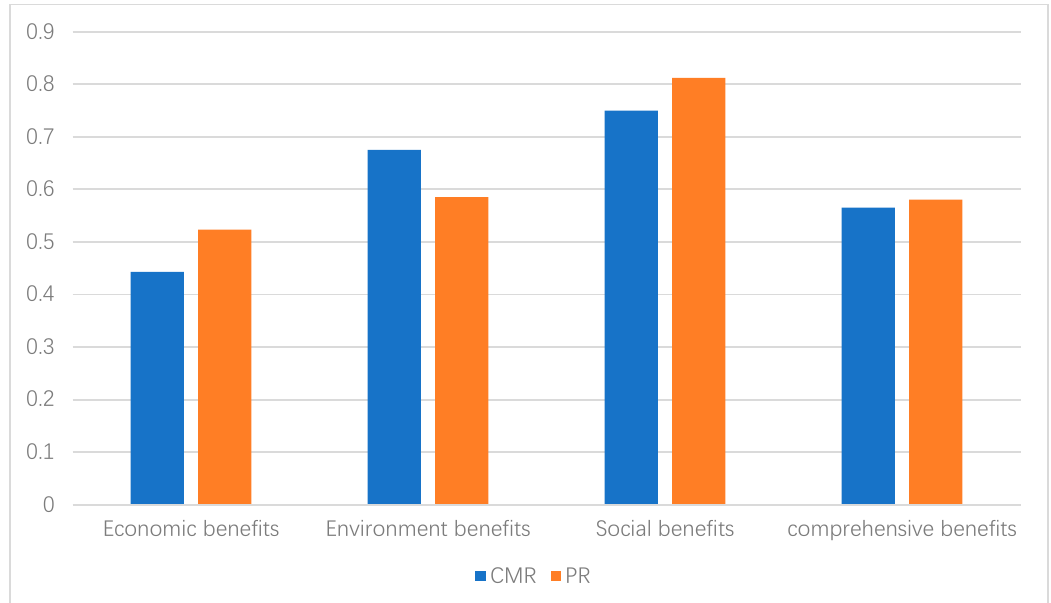
Figure 3. Comprehensive benefits error of CMR and PR strategies.